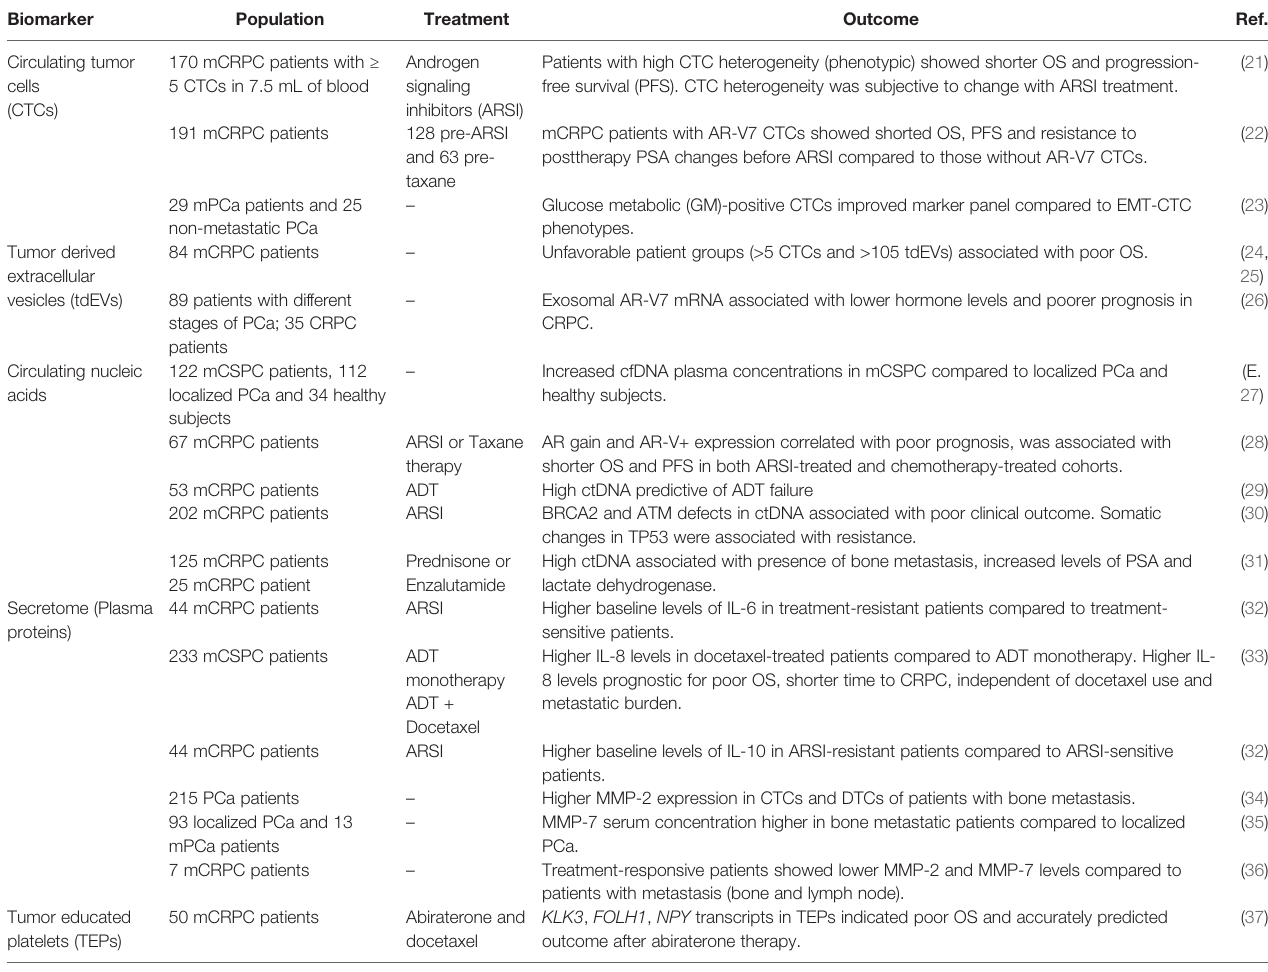
TABLE 1 | Summary of circulating biomarkers used in clinical studies and trials.